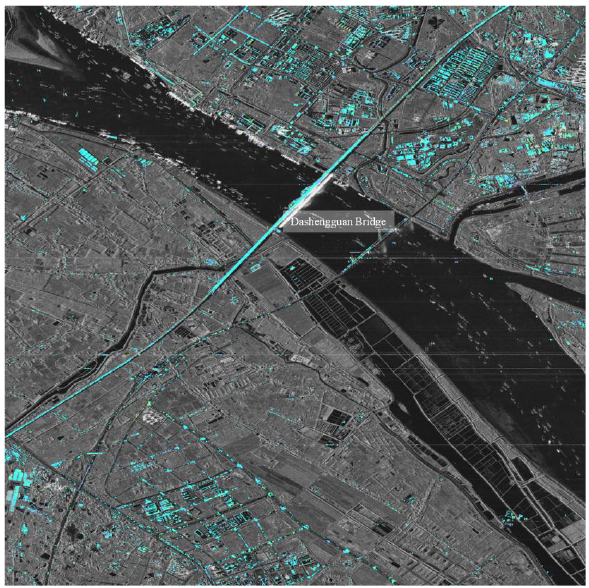
Figure 2. PS point distribution in study